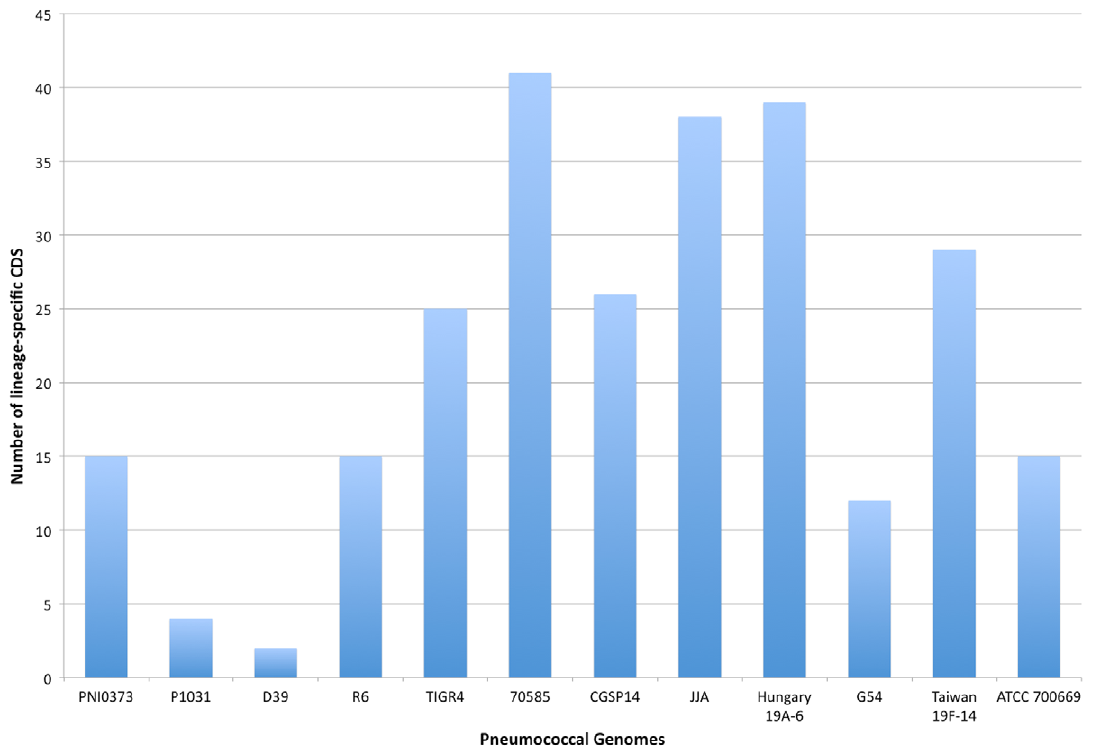
Figure 4. Lineage-specific CDS present in complete pneumococcal genomes. Genes present in only a single pneumococcal genome were identified using the following criteria: $ 50 codons in length and no significant blastp hits ( , 1e 2 10 ). Clonally related genomes, PNI0373 and P1031 as well as D39 and R6, contribute the least genic diversity to the pneumococcal pan-genome as they contain the fewest lineage-specific genes.